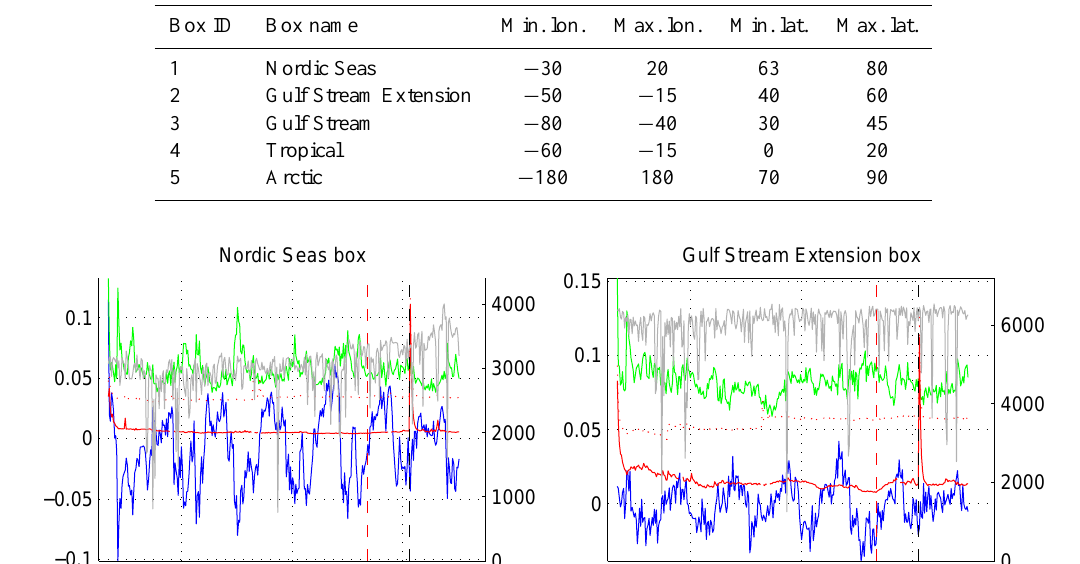
Table 2. Boxes used for innovation statistics (see also Fig. 1).